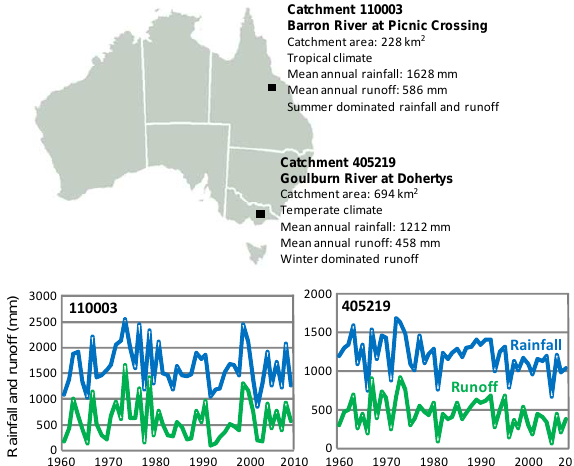
Figure 1. Locations of the two catchments used in the study and their annual rainfall and runoff time series